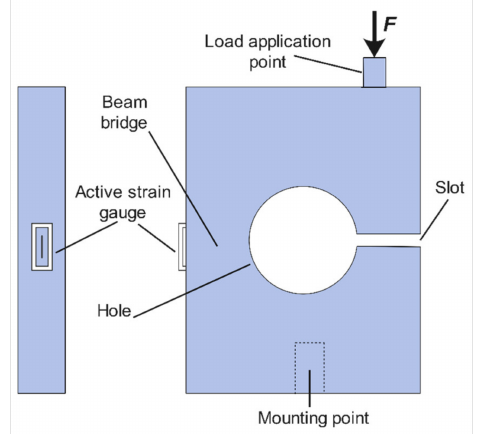
Figure 1. Structure of the load